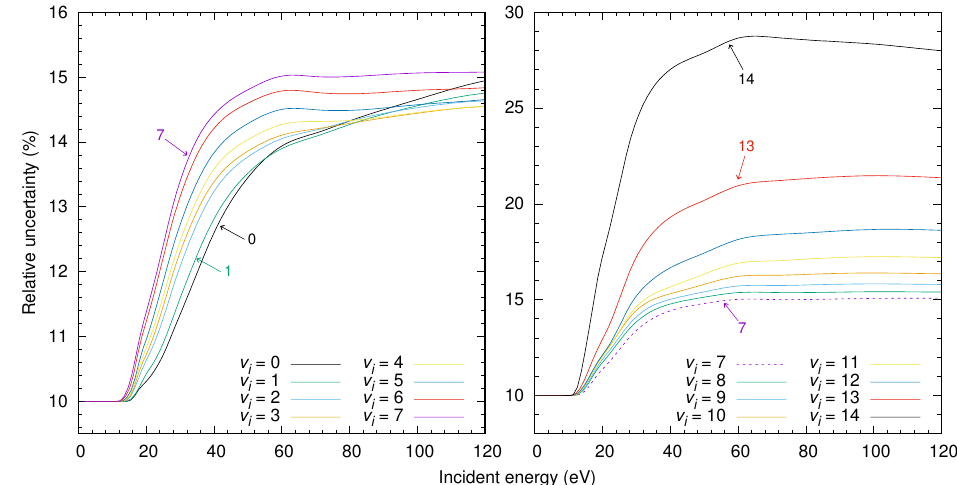
Figure 6. Relative uncertainty in the CCC dissociation cross section for each initial vibrational